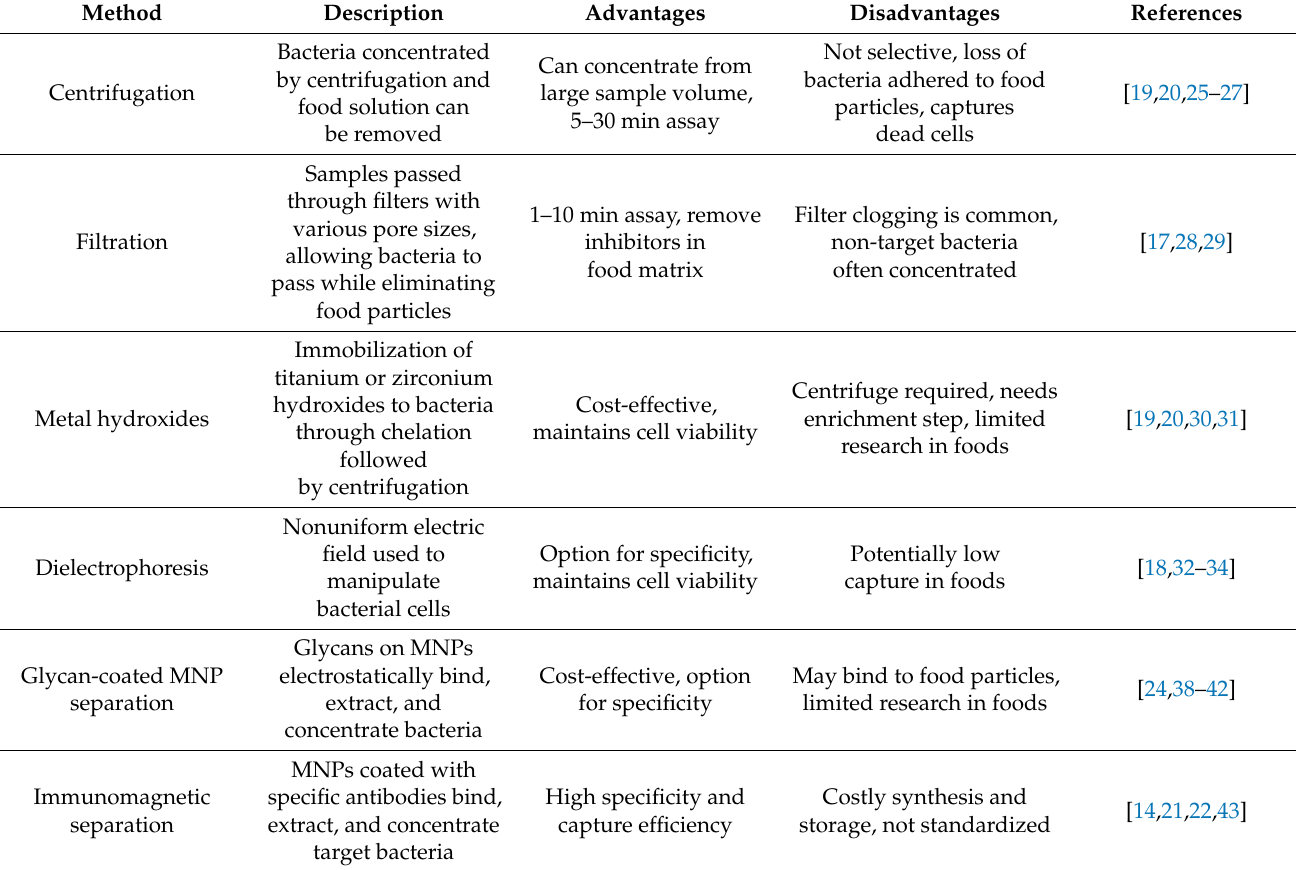
Table 1. Overview of existing methods for rapid bacteria concentration from food